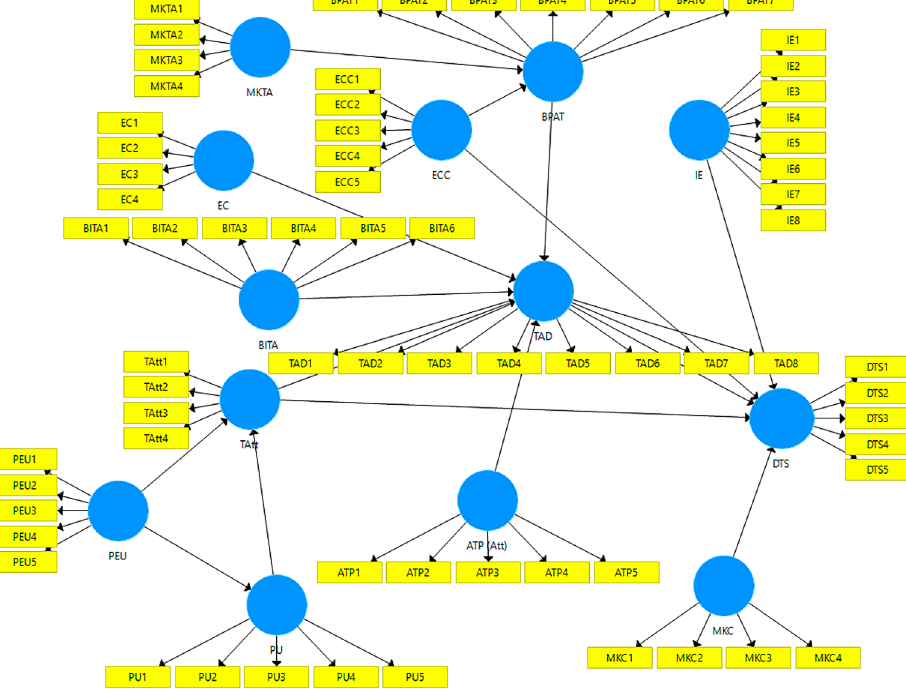
Figure 1. Initial theoretical path model (source: own